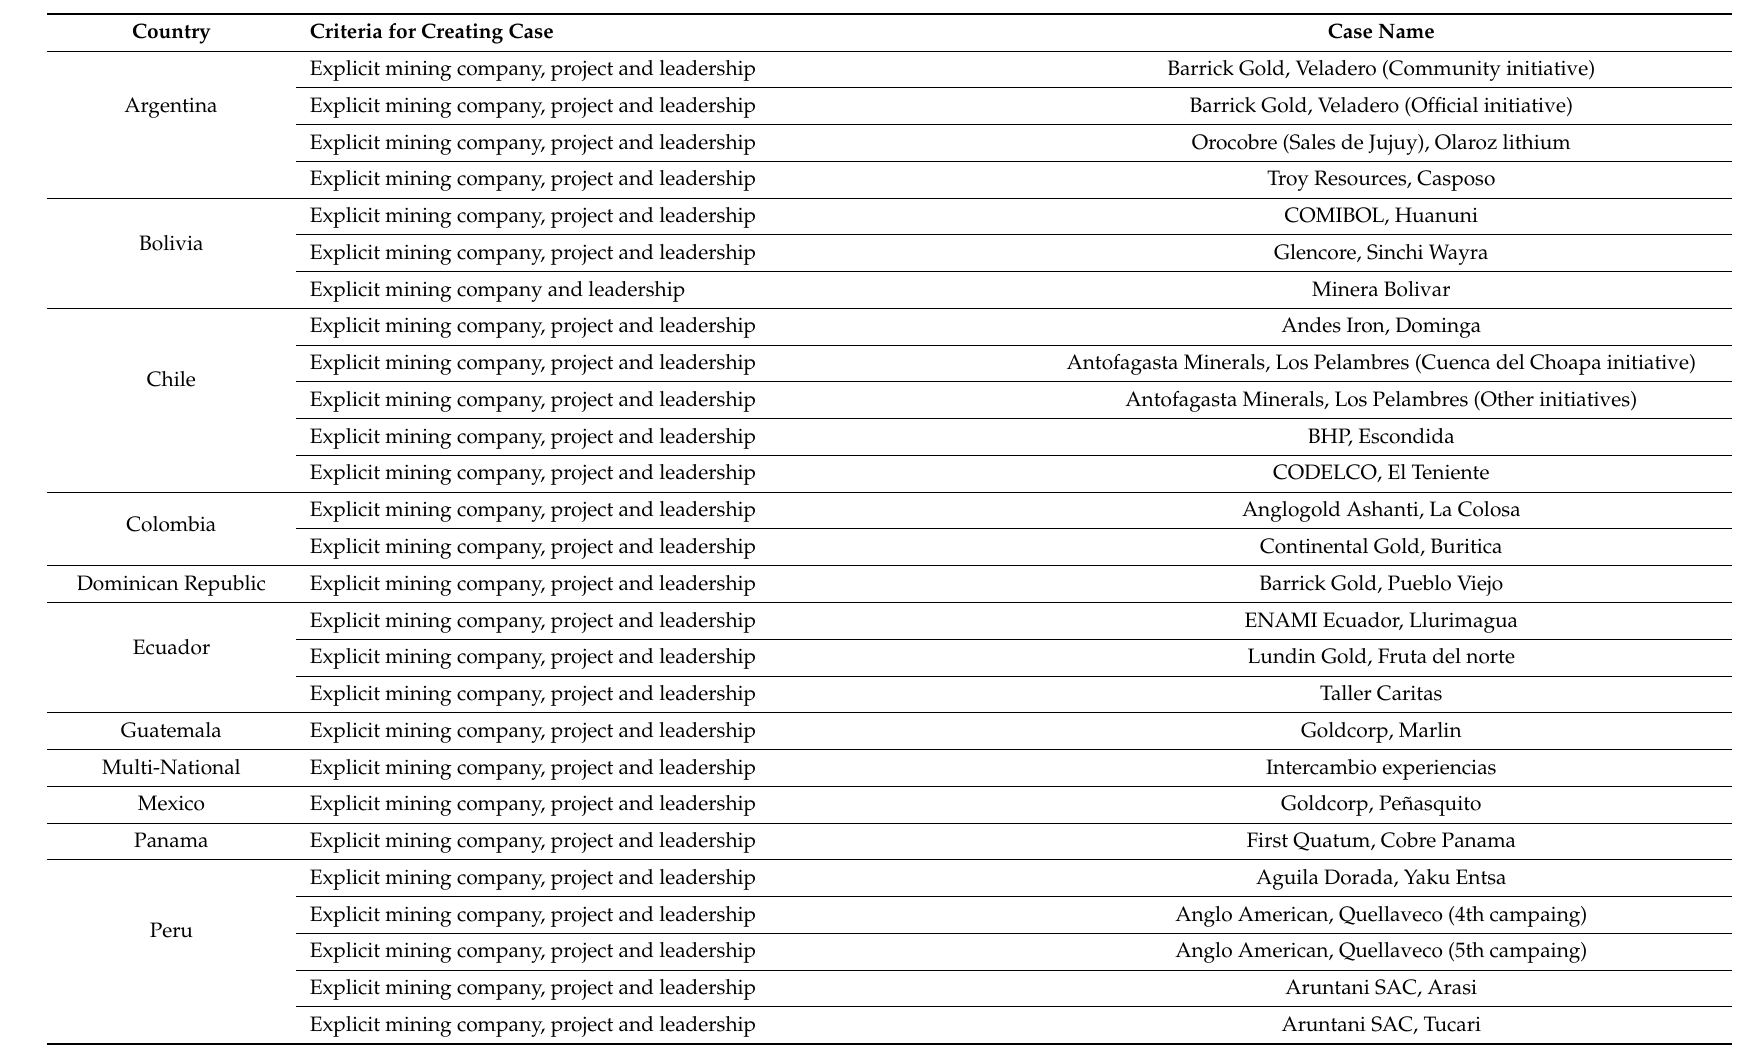
Table 1. PWM initiatives in Latin